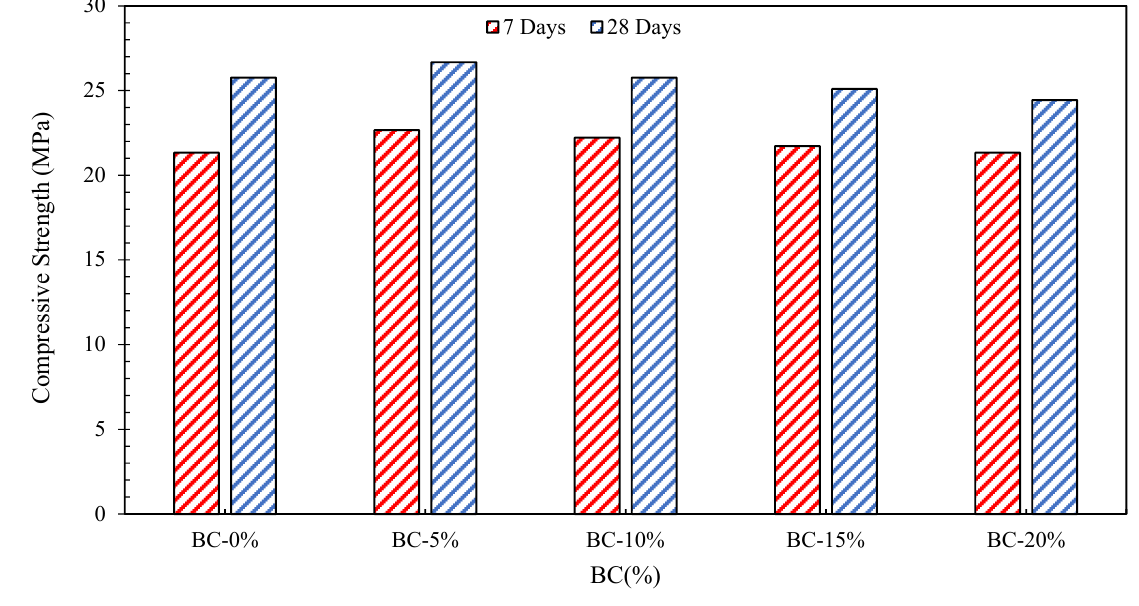
Figure 5. Compressive strength(data source [58]).